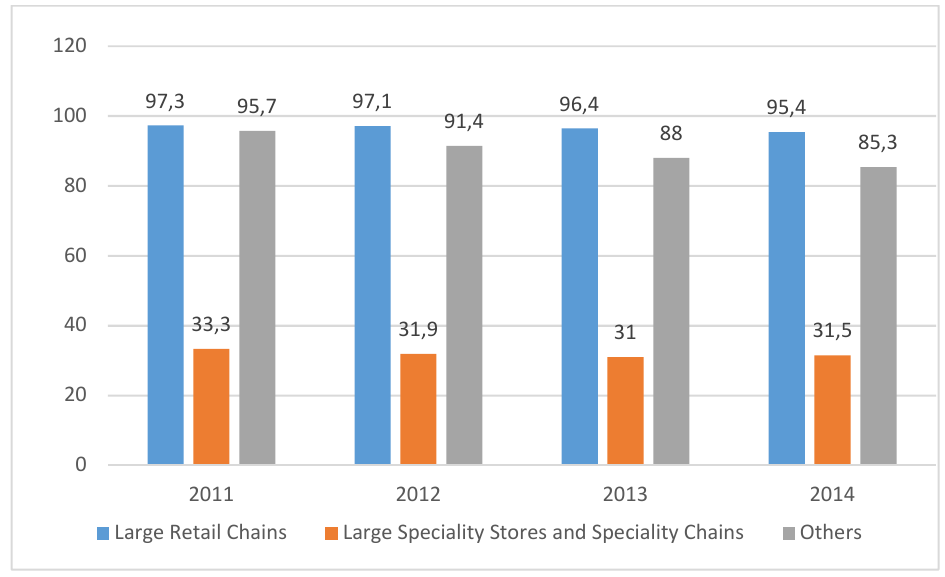
Figure 1: Turnover by Channel (billion euro) - Years 2011-2014